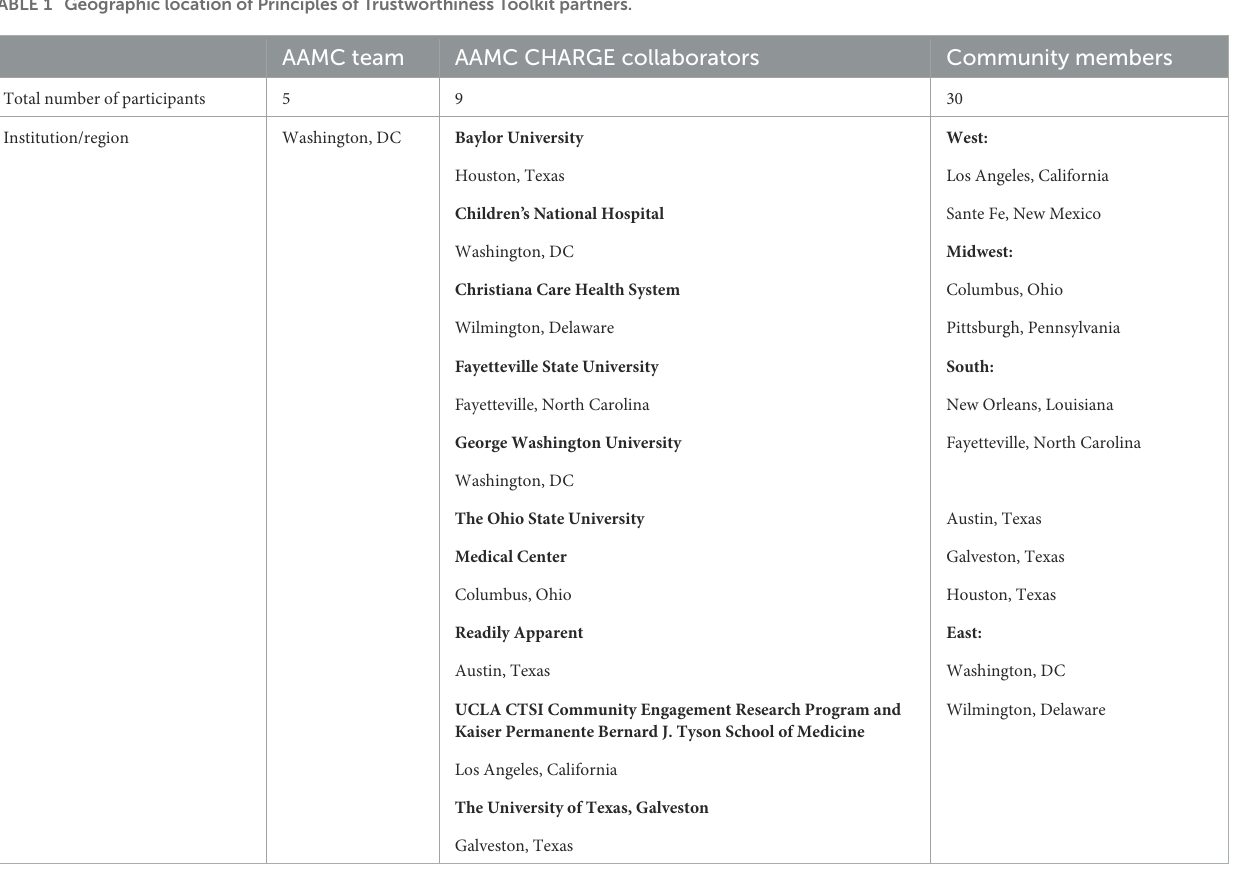
TABLE 1 Geographic location of Principles of Trustworthiness Toolkit